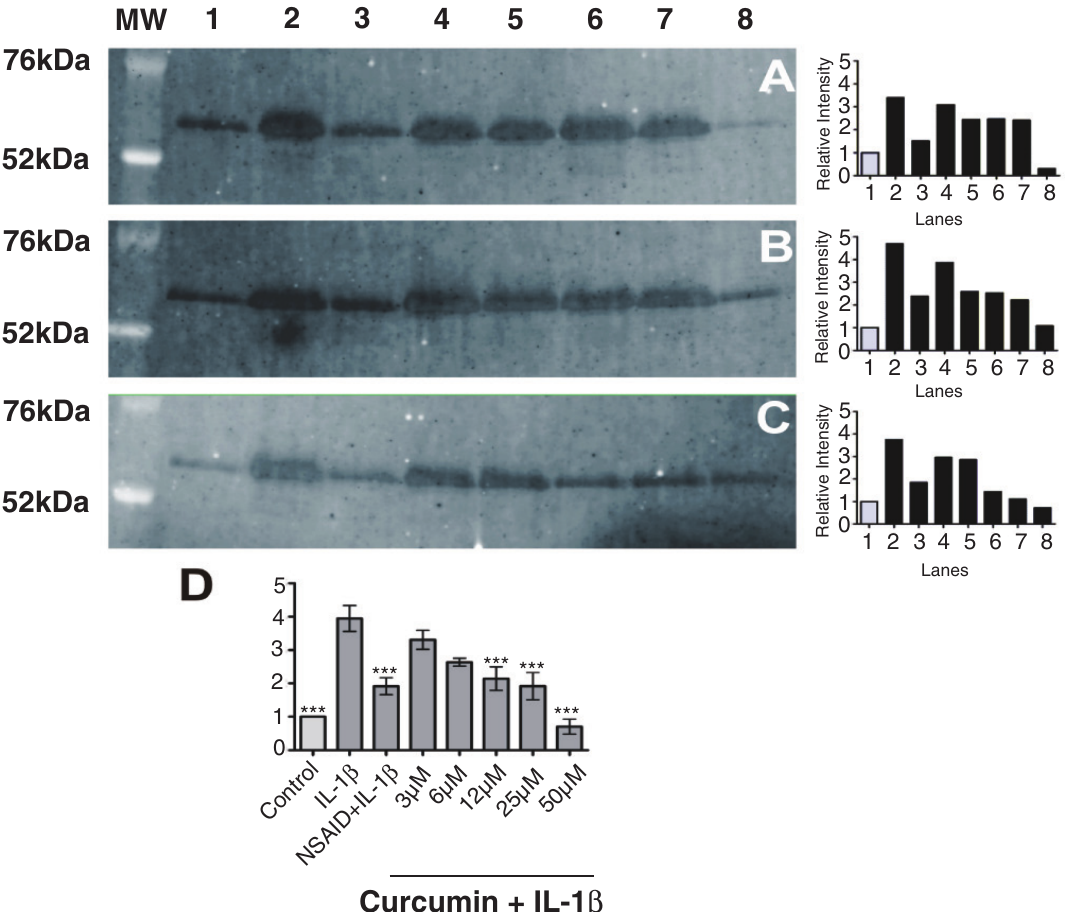
Figure 5. Western blot images and quantifying graphs of matrix metalloproteinase (MMP)-3 in the cartilage explant supernatants from three animals ( A , B , and C ). The lane on the left of the images shows the molecular weights (MW) of standard markers (Invitrogen, Paisley, Scotland, UK) in kilodaltons (kDa). Graph D shows the relative intensity of bands from all three animals with labeled treatment axes. Values are reported as the mean of three animals per treatment ± SEM. Significance compared to interleukin (IL)-1 β is indicated by ** ( p <0.01) and *** ( p <0.001). All lanes contain equal volumes of protein (50μg protein per lane). Unstimulated cartilage explants release low levels of MMP-3 as shown by the controls in lane 1. Secretion of MMP-3 from explants is significantly increased ( p <0.001) by IL-1 β (10ng/ml) (Lane 2). The non-steroidal anti-inflammatory drug (NSAID) carprofen (100μg/ml) (Lane 3) significantly reduces IL-1 β -stimulated MMP-3 secretion ( p <0.01) to near control levels. Curcumin at concentrations of 3μM (Lane 4) and 6μM (Lane 5) does not significantly reduce IL-1 β -stimulated MMP-3 release from the explants. However, a significant reduction is observed at 12μM ( p <0.01) (Lane 6), 25μM ( p <0.01) (Lane 7) and 50μM ( p <0.001) (Lane 8) from explants in a dose dependent manner. The extent of reduction differs between animals (one technical replicate was used from each